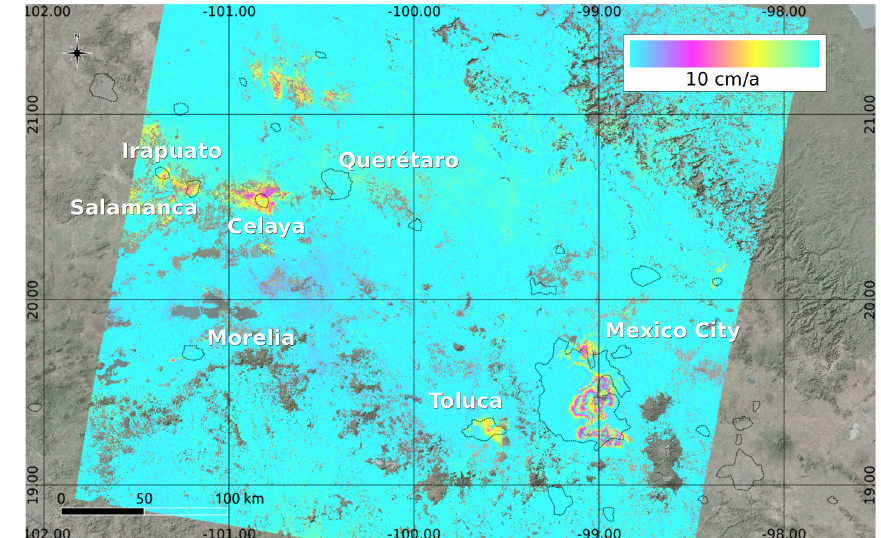
Figure 3. Land subsidence in central Mexico from ALOS-2 PALSAR-2 ScanSAR interferometry between 20 February 2015 and 16 Febru- ary 2018. A cyclic colour scaling model is employed to highlight larger rates of motion in Mexico City. Map data are from Bing Aerial (© Microsoft), urban areas extents from MODIS data (Schneider et al., 2009).